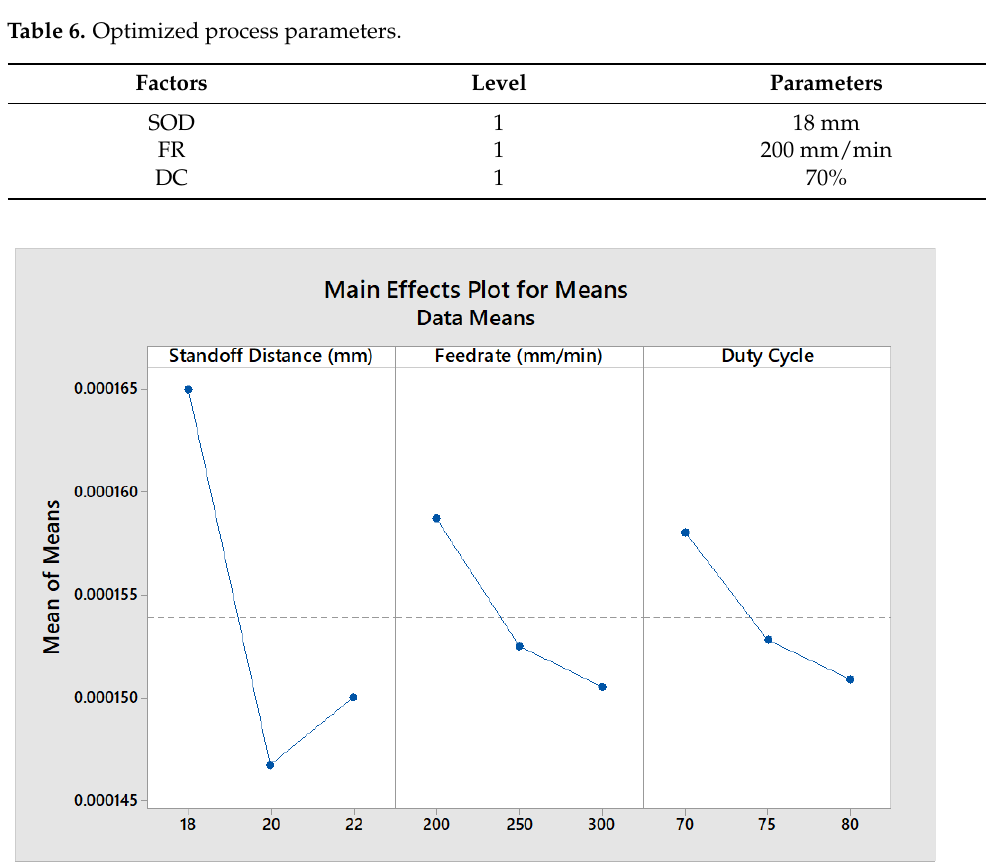
Table 6. Optimized process parameters.